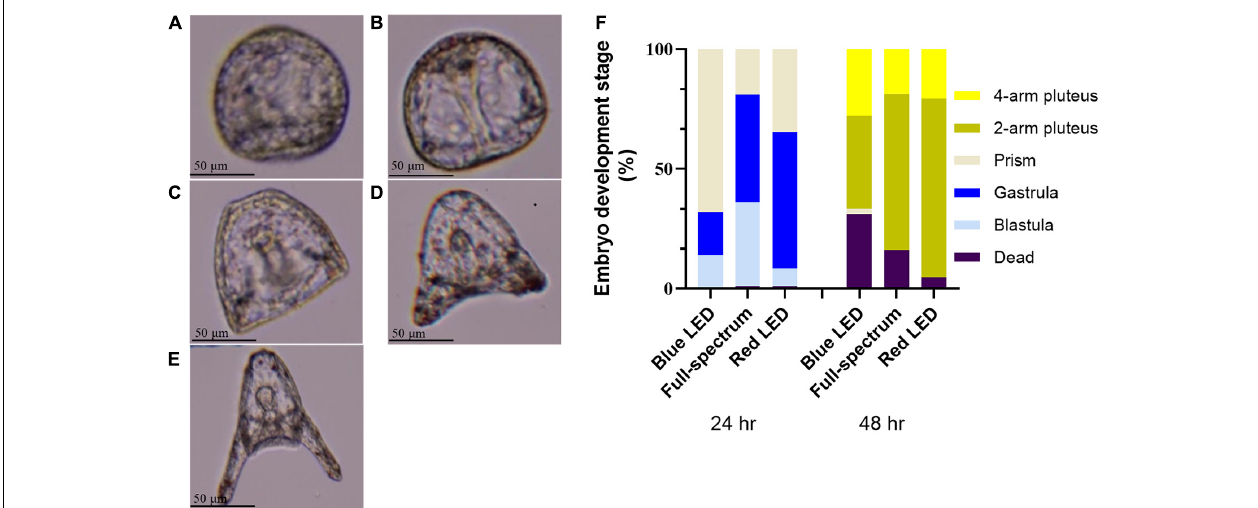
FIGURE 1 | Embryo developmental stages of T. gratilla under the compound microscopy. (A) blastula, (B) gastrula, (C) prism, (D) 2-arm pluteus, (E) 4-arm pluteus. (F) The percentage bar chart showing the proportion of embryo development stage at 24 and 48 h after fertilization under blue-, full-spectrum- and red LED